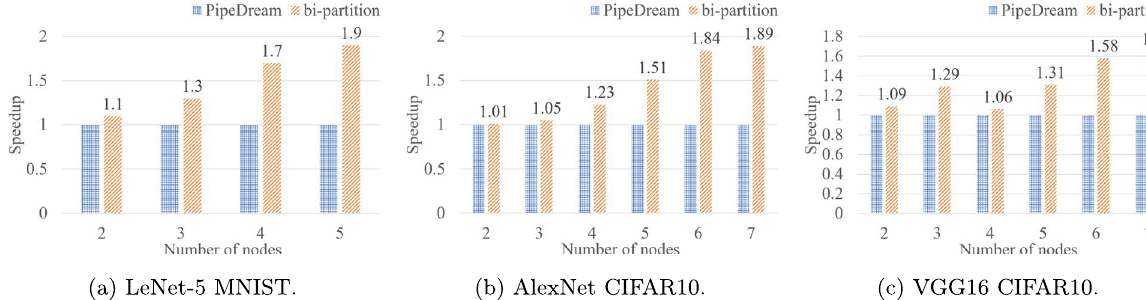
Fig. 8 Speedup on LeNet-5, AlexNet and VGG16 compared to PipeDream